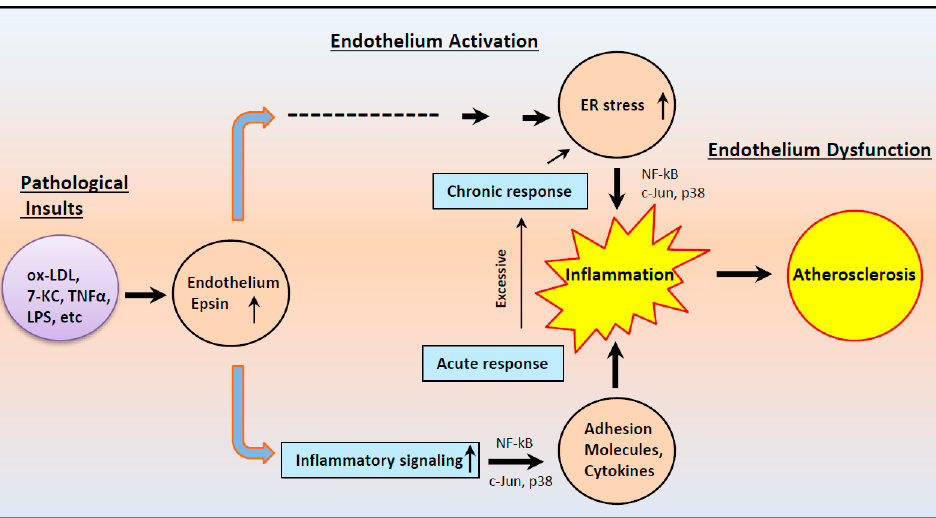
Figure 7. Schematic diagram of the role of epsins in mediating atherosclerosis. Under pathological conditions, endothelial epsin expression increases, which causes acute inflammatory signaling to activate endothelial cells to express adhesion molecules on the cell surface. These proteins attract immune cells that exacerbate inflammation. In the long-term, epsins affect ER homeostasis. The two pathways merge to aggravate inflammation, causing more endothelial dysfunction to accelerate atherosclerosis.